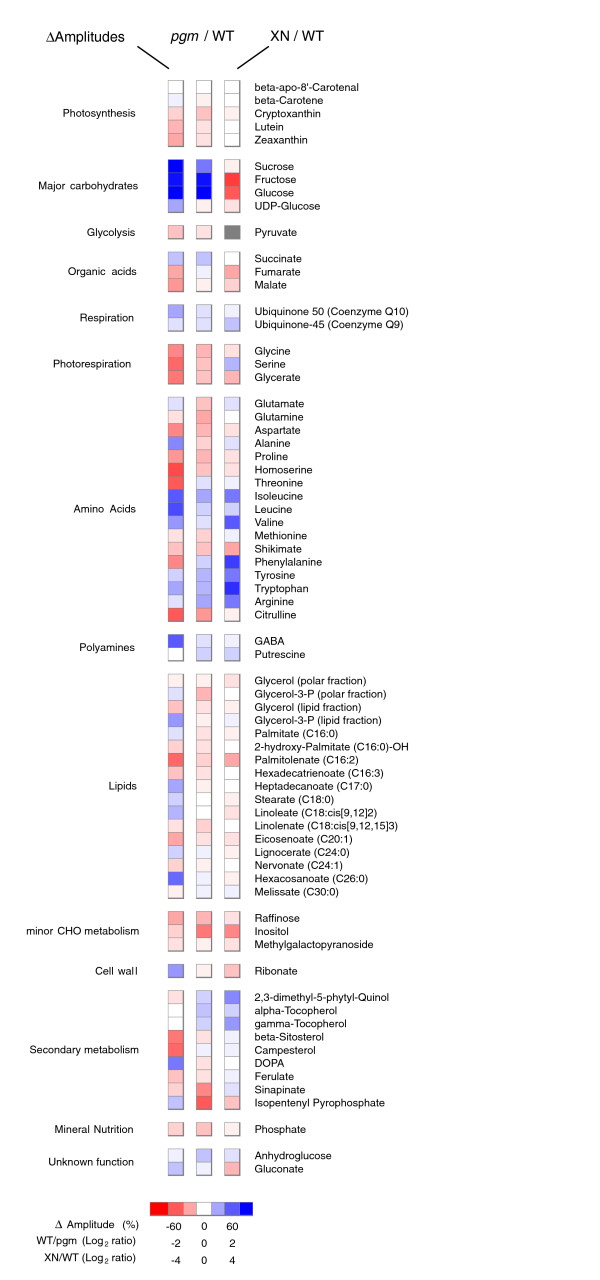
Comparative analysis of metabolite profiles obtained from Arabidopsis Col0 pgm and WT plants transferred to an extended night (XN). Heat map representing the differences in amplitudes of diurnal changes in individual metabolites calculated as maximum value - minimum value from smoothed data in WT and pgm (left); Log2 values of average (pgm) to average (WT) levels (middle), and Log2 values of average(WT) to 144 h XN (right). Scales are given in the legend.